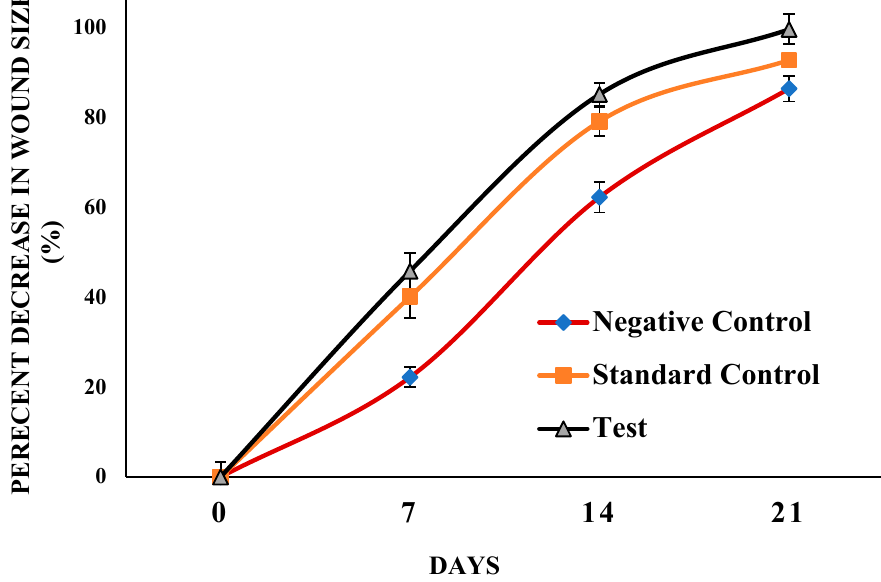
Figure 9. Decrease in wound sizes (%) wound healed by different treatments.at days 1, 7, 14 and 21 (Control, n = 4; STD, n = 4; TEST, n = 4; * p < 0.05).